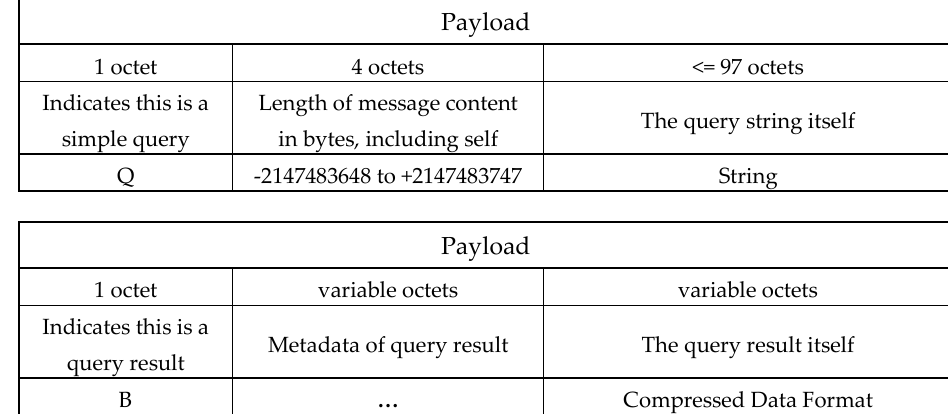
Figure 7. The format of IEEE 802.15.4.